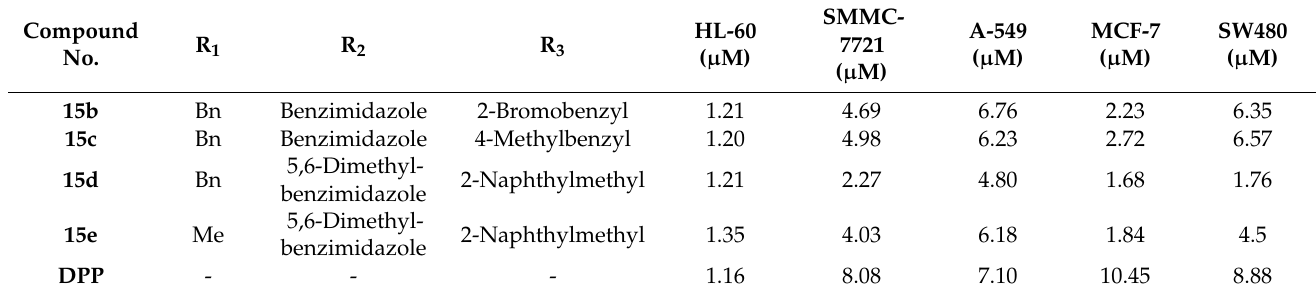
Figure 18. Structure of indole ‐ chalcone based hybrids and the most promising compound 16a. Table 16. In vitro cytotoxic activities of indole ‐ chalcone based hybrid compounds 16 ( b – e ). Compound No.